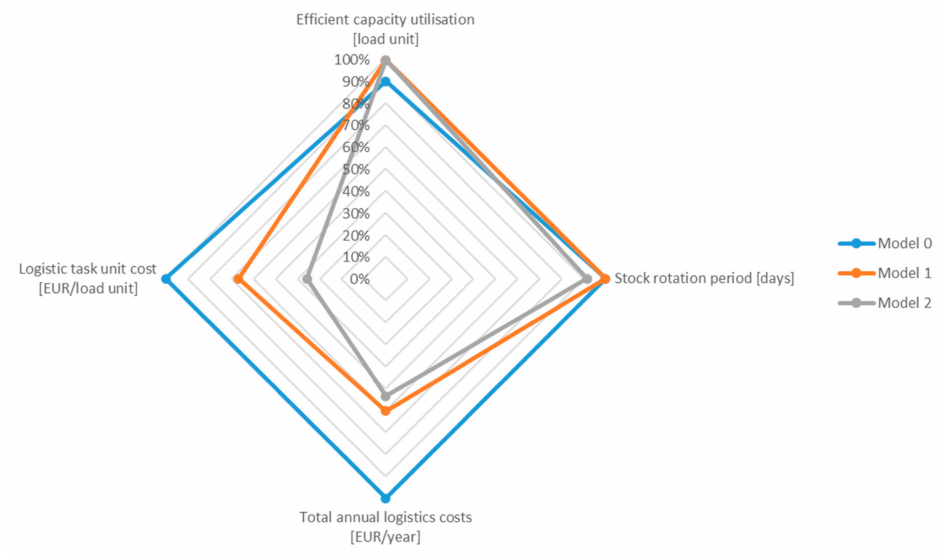
Figure 10. Results of the PL9A modeling of the Logistics System—Group 4—Logistics System Efficiency. Models 1 and 2 ensure the most effective use of the capacity of the logistical system, which results from the use of the free-storage method (Figure 10). Block storage in Model 0 requires 10% more logistics system capacity to handle the assumed level of